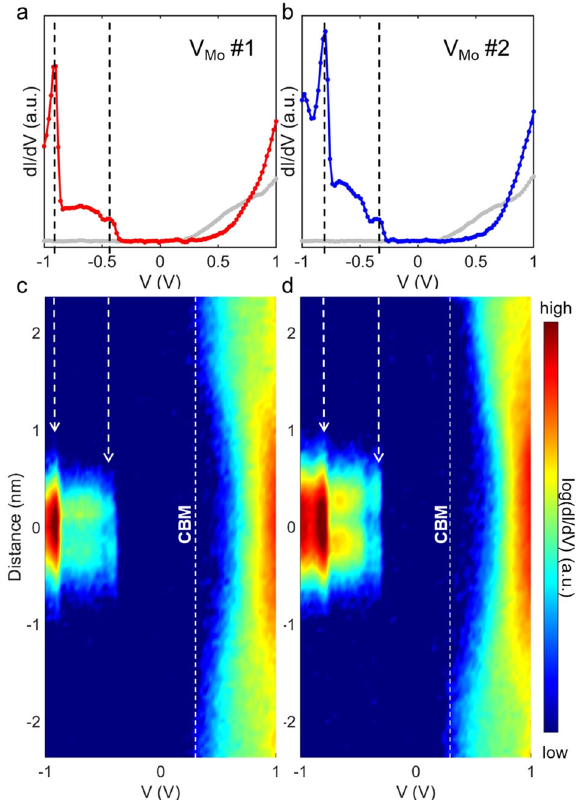
Fig. 3 Local band bending. a , b STS acquired on top of the charged defect #1 (red) and #2 (blue), respectively, with the spectrum acquired on the pristine MoS 2 fi lm (gray) plotted for comparison ( V set = 1.0 V, I set = 100 pA). The black dashed lines represent the energies of the a 1 -pd and e-pd states. c , d STS line pro fi les of length 4.75 nm centered over the defects in ( a , b ), respectively. The white dashed arrows represent the a 1 -pd and e-pd states while the white dashed line labeled CBM represents the energy of the conduction band minima of the pristine MoS 2 fi